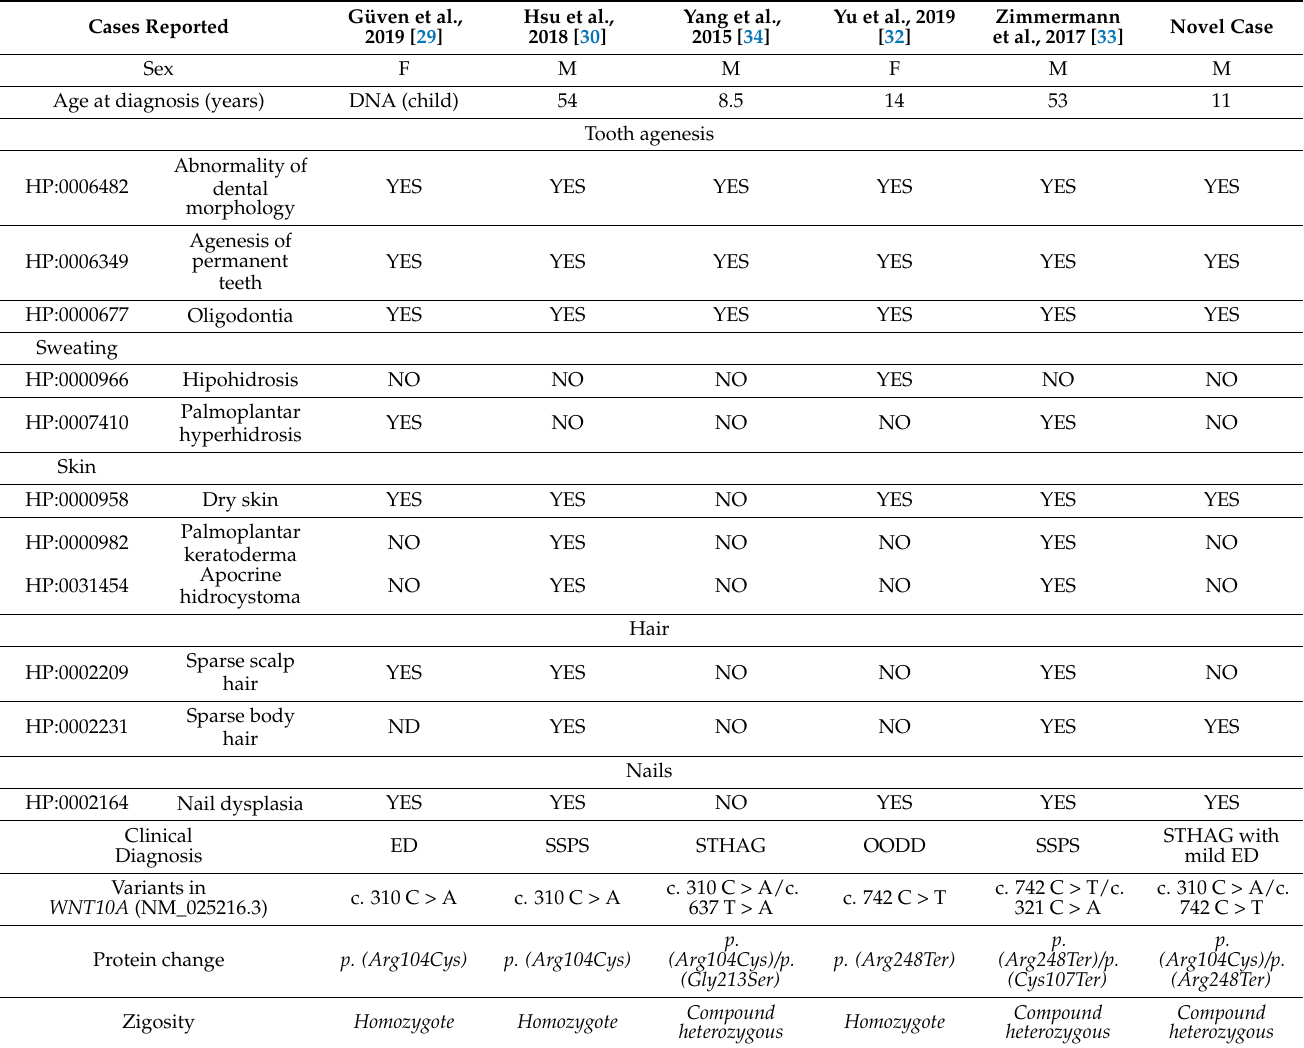
Table 2. Clinical features described in cases with referred variants in homozygous or compound